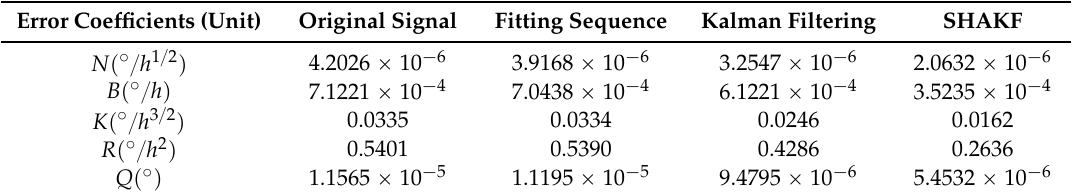
Table 1. Comparison of the noise source error coefficients before and after